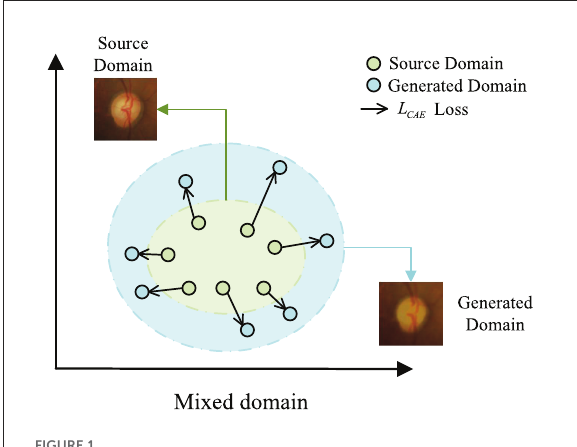
FIGURE1 The motivation of L CAE . We expect to create out-of-domain augmentations by maximizing the loss L CAE .